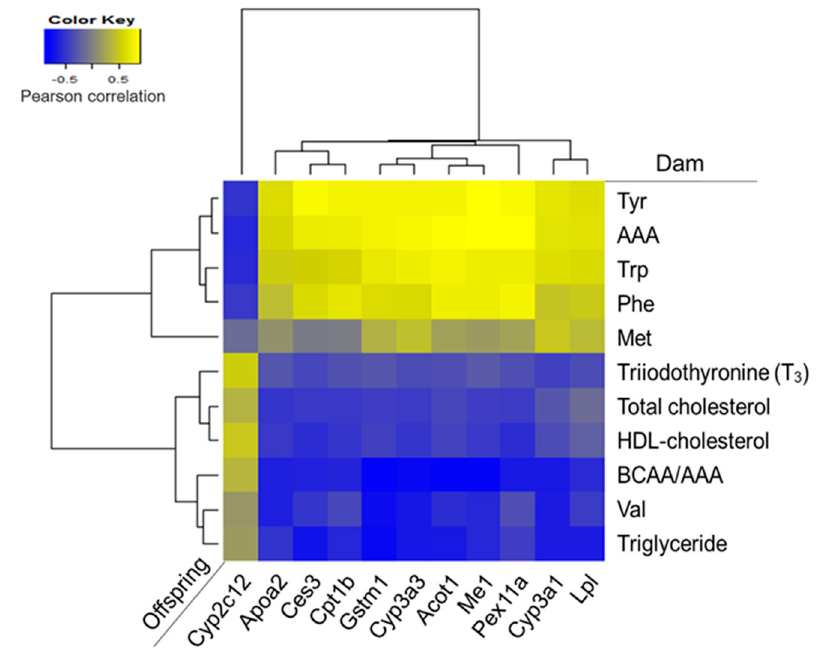
Figure 6. Heat map of Pearson correlation coefficients between serum parameters in dams and hepatic expressions of PPAR α -target genes in offspring. Yellow color represents positive correlation and blue color represents negative correlation.